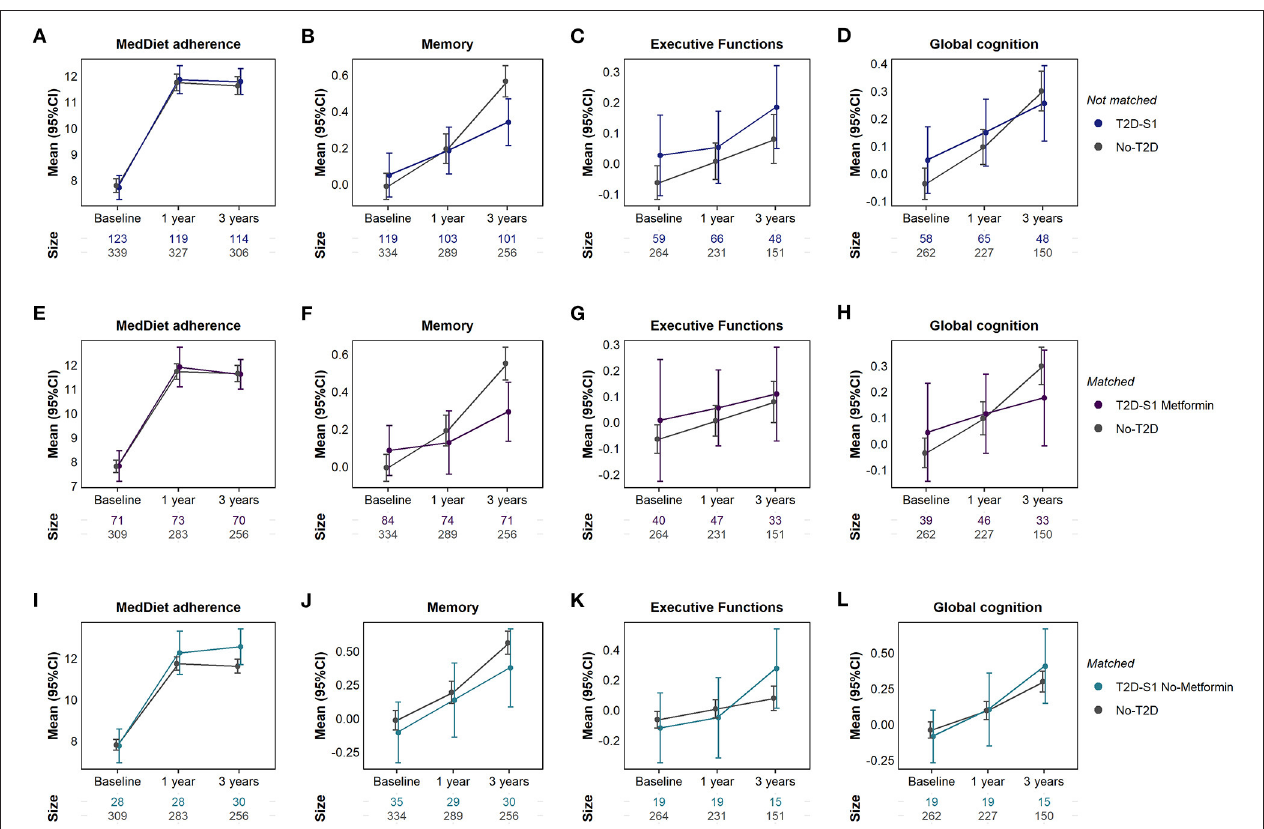
FIGURE 4 | Differences in MedDiet adherence, memory, executive functions and global cognition between subjects without type 2 diabetes (No-T2D) and all subjects with type 2 diabetes from subgroup 1 (T2D-S1) (A–D) ; T2D-S1 treated with metformin (E–H) and T2D-S1 not treated with metformin (I–L) . In comparisons (E-L) subjects with and without type 2 diabetes were matched with inverse probability of treatment